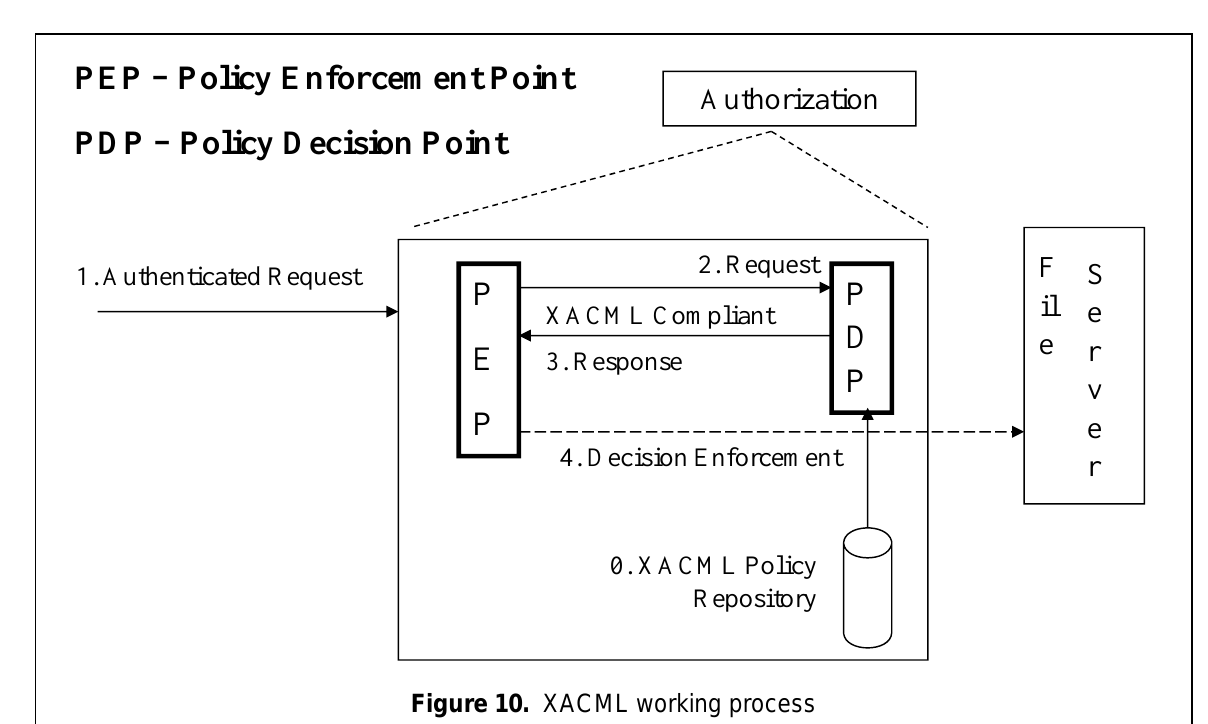
Figure 10. XACML working